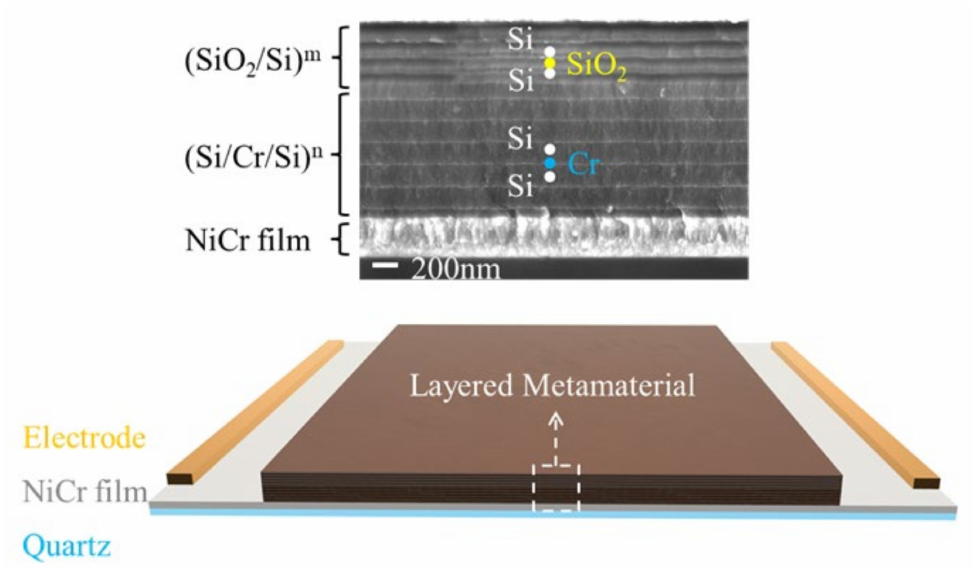
Figure 1. A schematic of the LMM thermal emitter with integrated electric heating